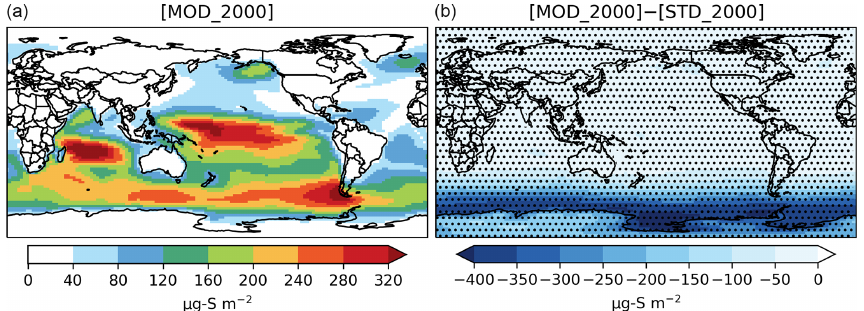
Figure 2. Spatial distribution of the annual mean column concentration (micrograms of sulfur per meter squared; hereafter µgSm − 2 ) for DMS simulated by [MOD_2000] (a) and its difference from the baseline run, i.e., [MOD_2000]–[STD_ 2000] (b) . Dotted regions (nearly worldwide) indicate where statistically significant differences are identified by grid-by-grid two-sample t tests with p values < 0.05.